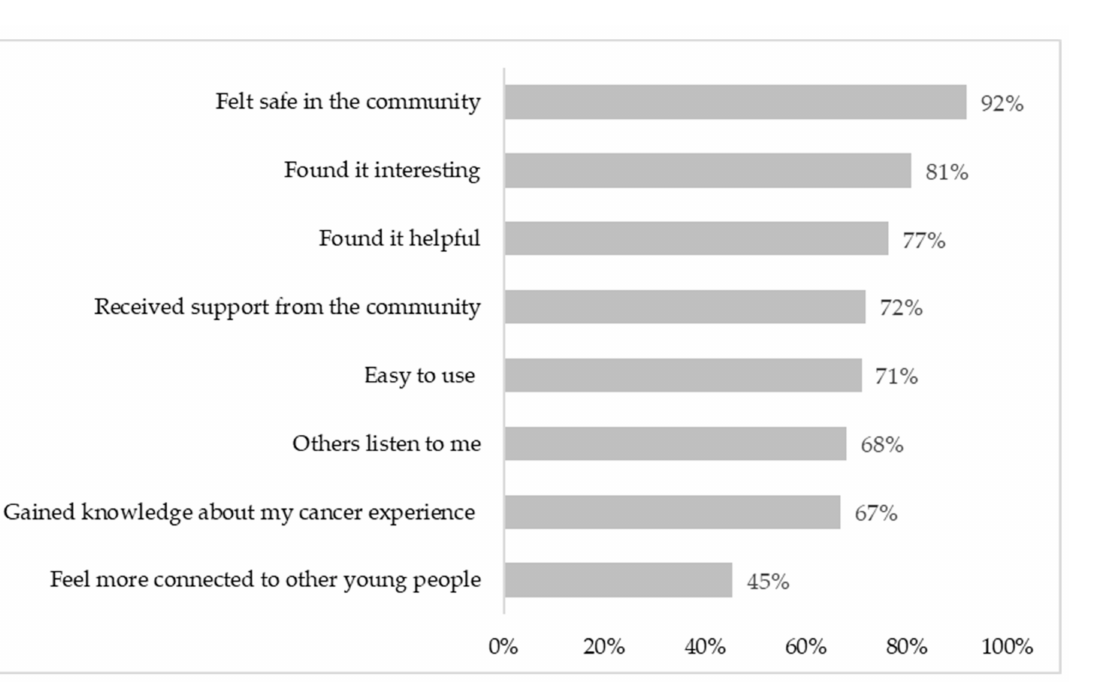
Figure 5. Acceptability of Canteen Connect version